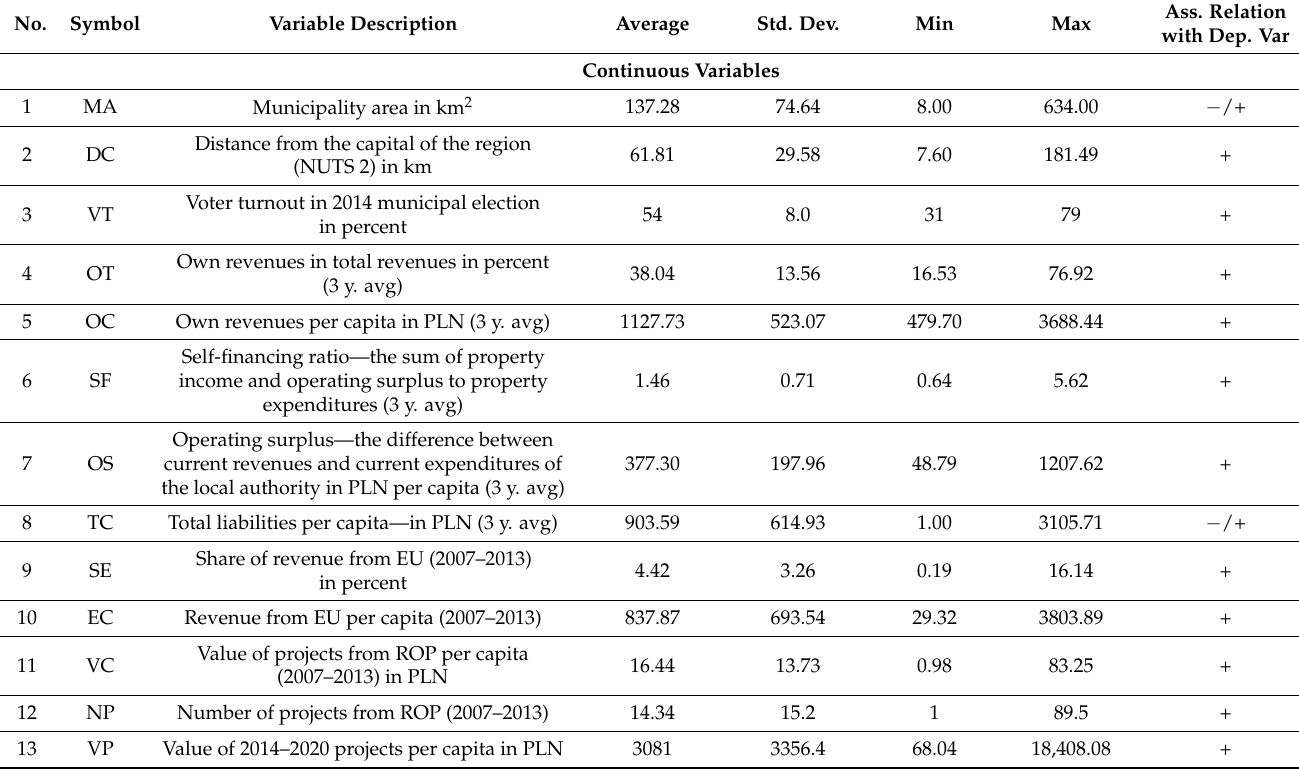
Table 5. Independent variables used to construct the multinomial logit